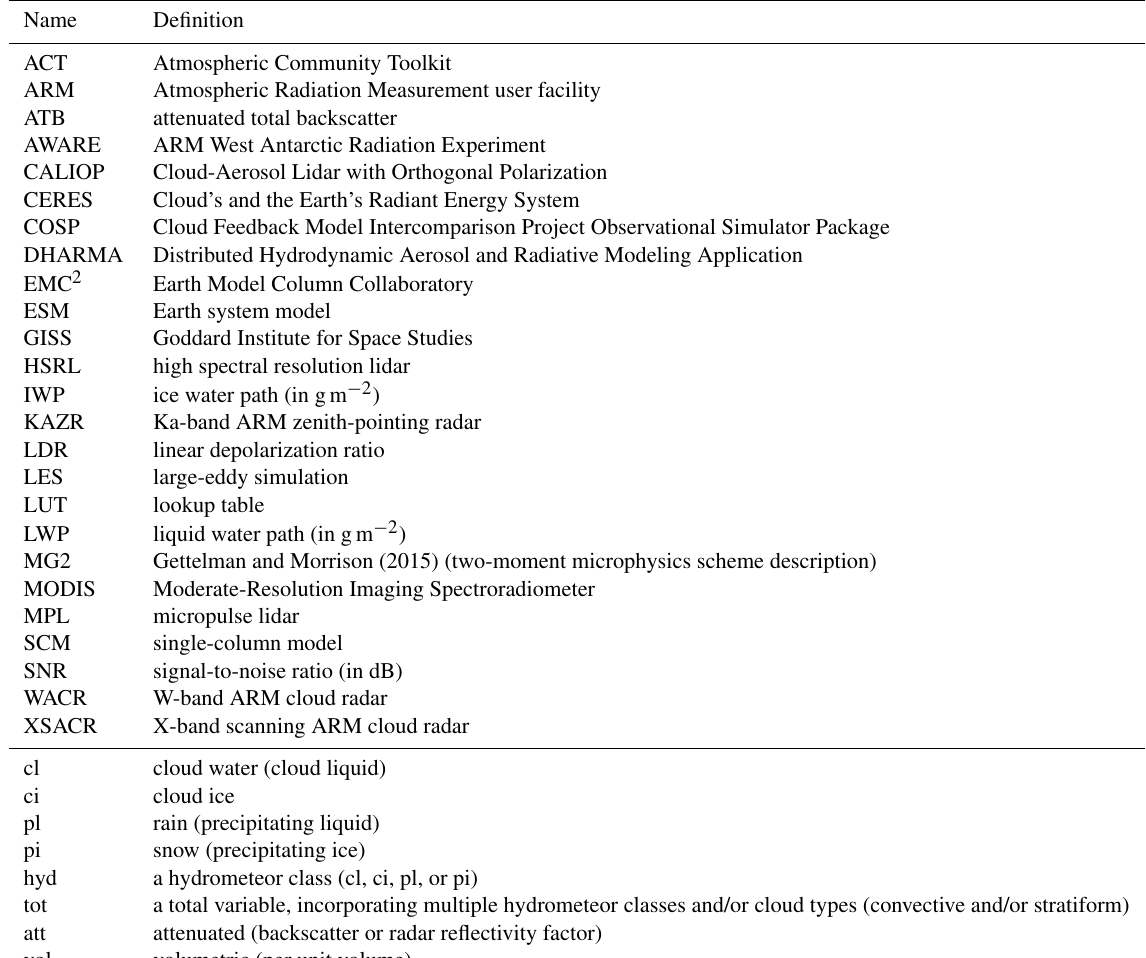
Table A1. Acronyms and subscript abbreviations used in this